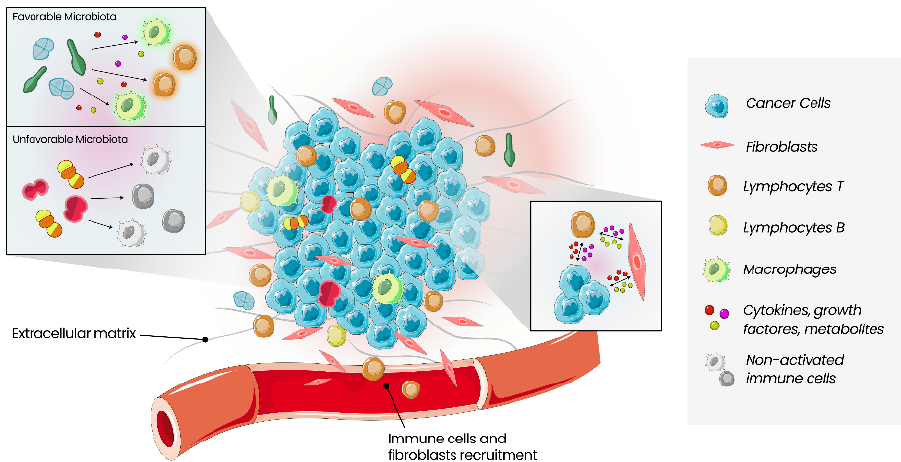
Figure 1. Schematic of the main constituents of the tumour microenvironment. Cancer cells, stromal cell types and immune cells coexist in the tumour microenvironment, interacting via cytokines, growth factors and metabolites. The antitumour activity of immune cells is regulated by the balance between co-stimulatory and co-inhibitory signals. Local microbiota can influence the immune response in a stimulating or inhibitory way, depending on the type of bacteria present.